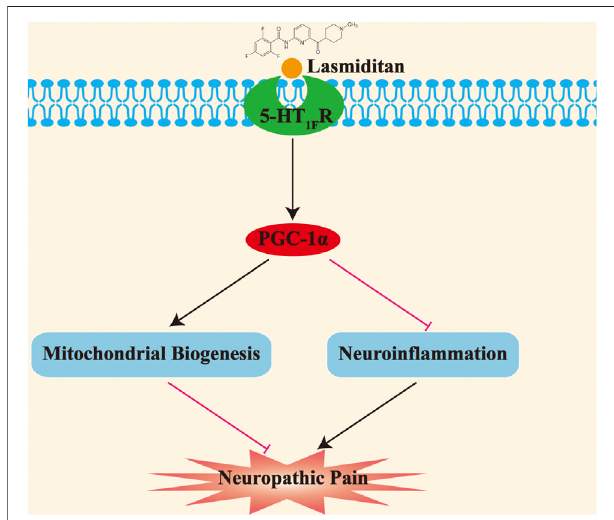
FIGURE 10 | Schematic diagram demonstrating that activation of 5- HT 1F receptor improves mechanical allodynia induced by neuropathic pain. The impaired mitochondrial biogenesis promotes the development of neuropathic pain; moreover, activation of 5-HT 1F receptor with lasmiditan ameliorates mechanical allodynia induced by neuropathic pain through prompting mitochondrial biogenesis and suppressing neuroin fl